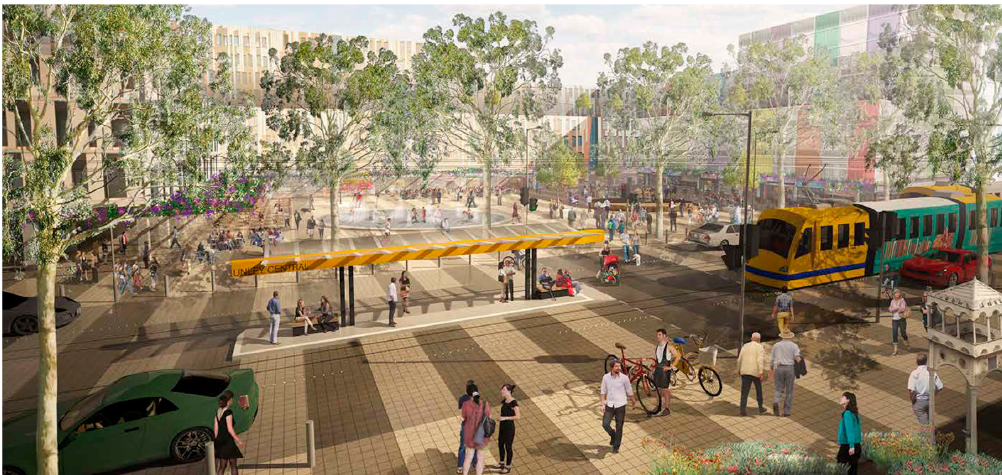
Figure 6. Depiction of Unley Central’s District Centre Zone, looking East across Unley Road [29].